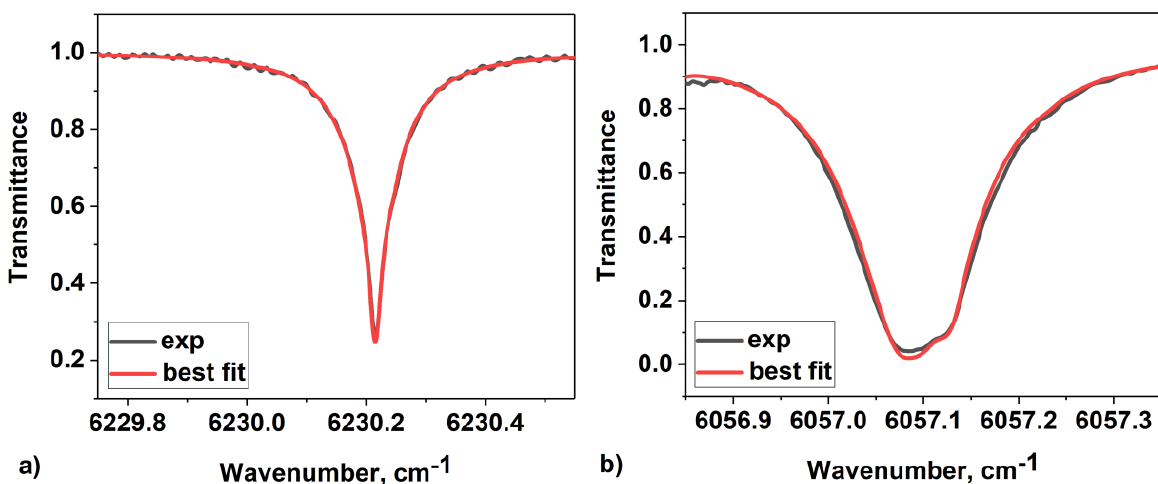
Figure 5. Experimental data of the ground-based MLHS prototype recorded within 2 min period of integration. Black curves are experimentally measured atmospheric spectra; red curves are synthetic ones. Spectra were measured at different times, i.e., not simultaneously. ( a ) An isolated absorption line of the CO 2 band at 1605 nm (6230 cm −1 ), column CO 2 concentration is 406 ± 3 ppm. ( b ) A quartet of isolated CH 4 lines at 1651 nm (6057 cm −1 ), column CH 4 concentration is 1.838 ± 0.008 ppm. The error budget is estimated by a repeated retrieval procedure based on disturbed synthetic data. An oscillating component of measured spectra, which may be noticed in the signal, results from a parasitic interference in the fiber optical system that becomes noticeable due to a high SNR.